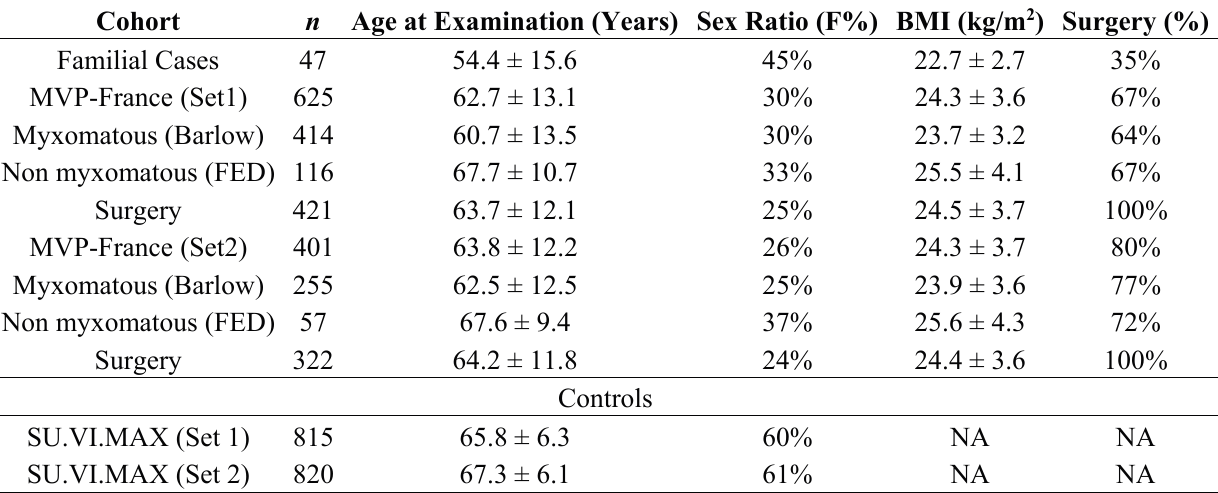
Table 1. Characteristics of mitral valve prolapse populations and